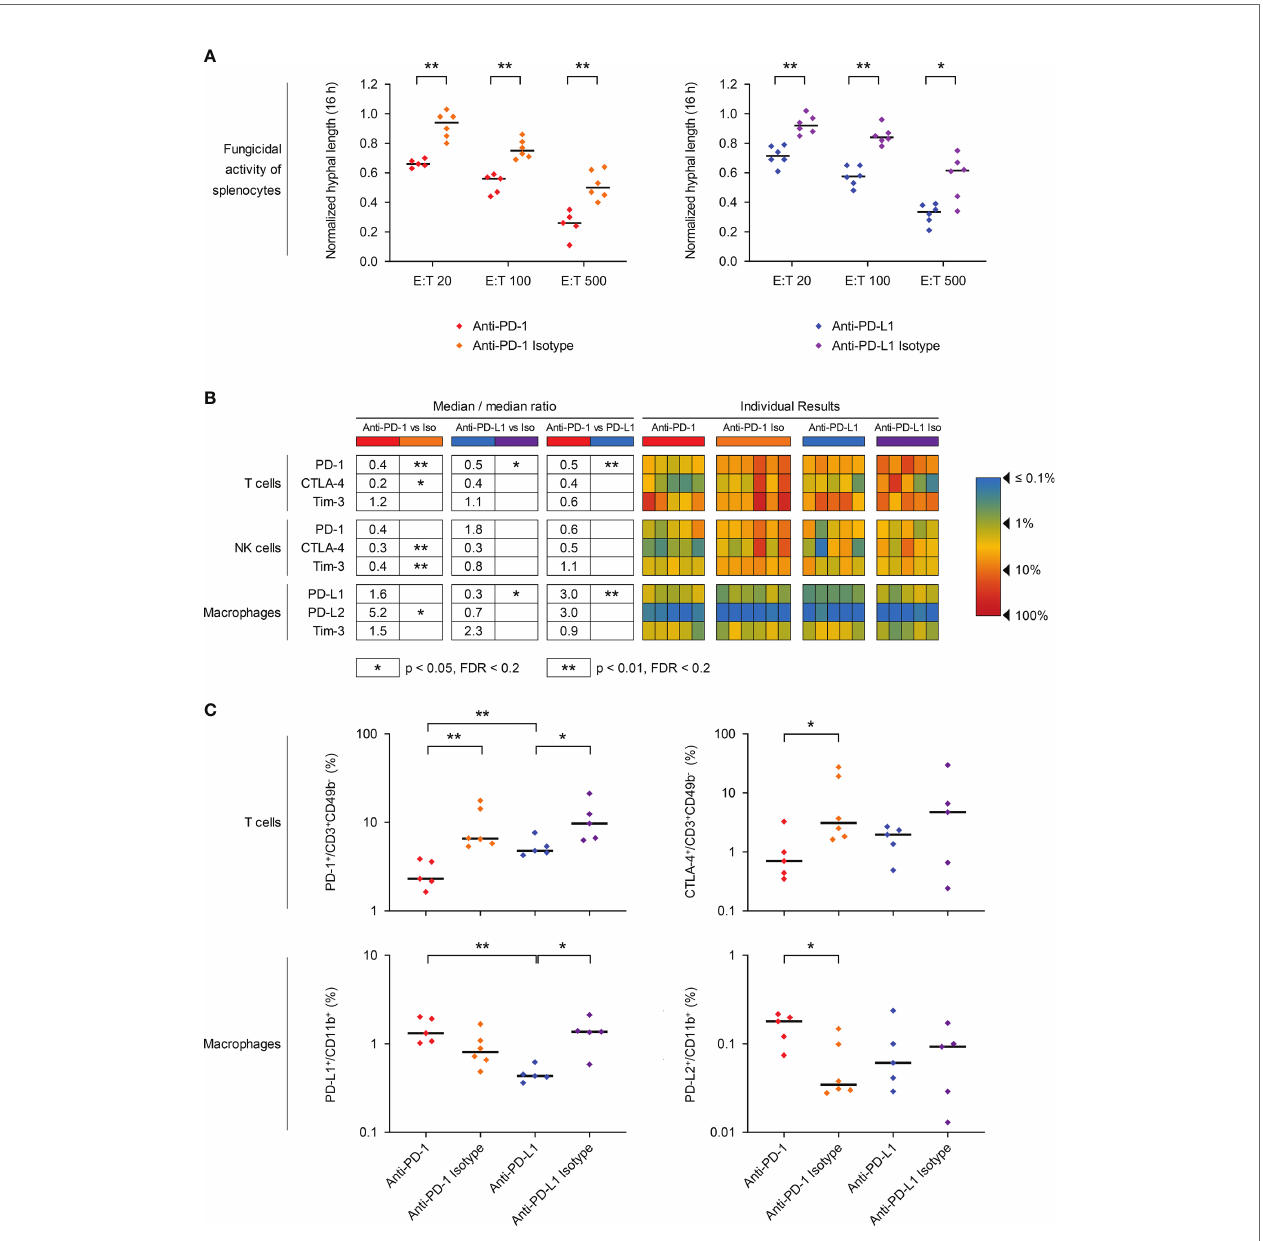
FIGURE 3 | PD-1/PD-L1 axis blockade in mice with invasive pulmonary mucormycosis (IPM) counteracts T-cell exhaustion and enhances the fungicidal activity of ex vivo splenocytes. (A) Ex vivo splenocytes from mice with IPM were co-cultured with a GFP-expressing R. arrhizus strain at different effector/target (E:T) ratios and imaged in the IncuCyte time-lapse microscopy system, as described in Materials & Methods. Hyphal length after 16 h of fungus/splenocyte co-culture, normalized to the “ fungus only ” control (= 1.0), is shown. Individual results for each mouse (n = 5-6 per group) and medians are provided. MMR = median-to-median ration. Mann- Whitney U-test. (B, C) Splenic immune cells were isolated from mice with IPM that received ICI treatments or isotype controls and survived the infection for 7 days. The percentages of PD-1, CTLA-4, and Tim-3 expressing T cells (CD3+ CD49b-) and NK cells (CD3-CD49b+) as well as the percentages of PD-L1, PD-L2, and Tim-3 expressing macrophages (CD11b+) were quanti fi ed by fl ow cytometry. (B) Heat map summarizing the individual frequencies of checkpoint marker-positive cells. (C) Individual and median frequencies (black bars) of selected exhaustion markers are shown. Mann-Whitney U test with Benjamini-Hochberg correction for a false discovery rate of 0.2. * p< 0.05, ** p < 0.01. CD, Cluster of Differentiation; CTLA-4, Cytotoxic T-lymphocyte-Associated Protein 4; MMR, median-to-median ratio; PD-1, Programmed Cell Death Protein 1; PD-L1/2, Programmed Death-Ligand 1/2; Tim-3, T-cell Immunoglobulin and Mucin-Domain